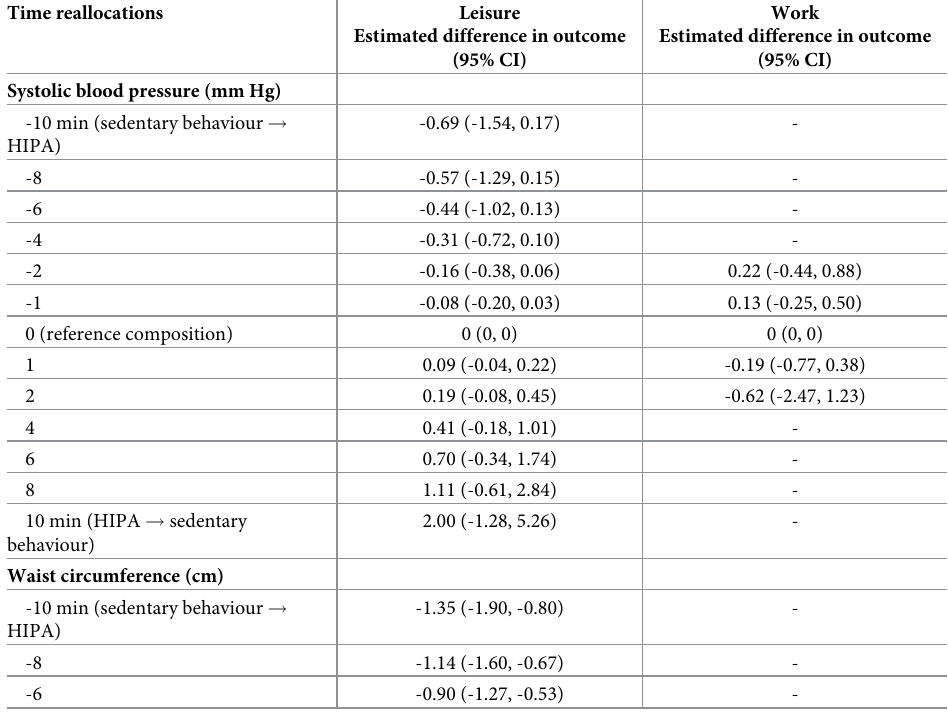
Table 4. Estimated adjusted differences in systolic blood pressure, waist circumference, and low-density lipopro- tein cholesterol given time reallocations between sedentary behaviour and high intensity physical activity during leisure and work among 652 adults in the fifth examination of the Copenhagen City Heart Study. Time